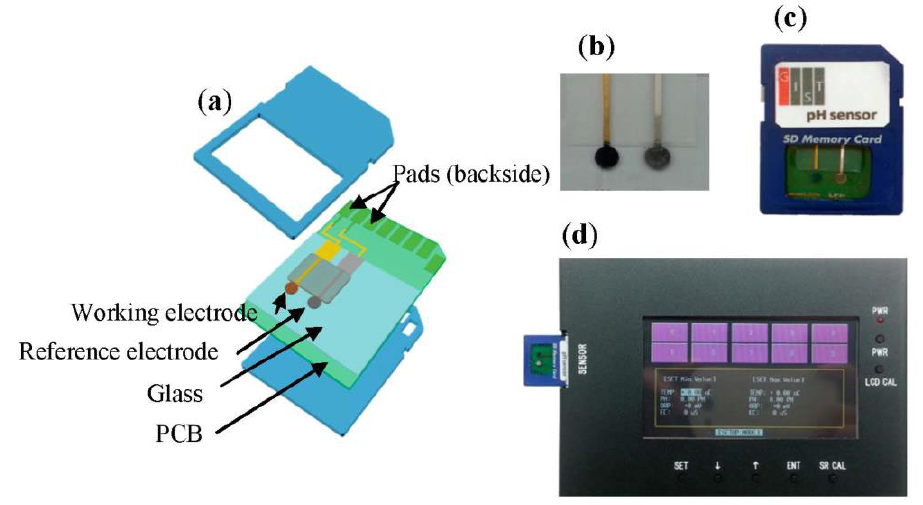
Figure 2. The SSRE coated with GO and the pH working electrode were built on a square-shaped glass substrate. ( a ) Schematic showing the individual parts of the sensor; ( b ) Photograph of the actual sensor fabricated on a glass substrate; ( c ) Photograph of the sensor packaged in an SD card; ( d ) Laboratory-made potentiometer that was used in the integrated pH